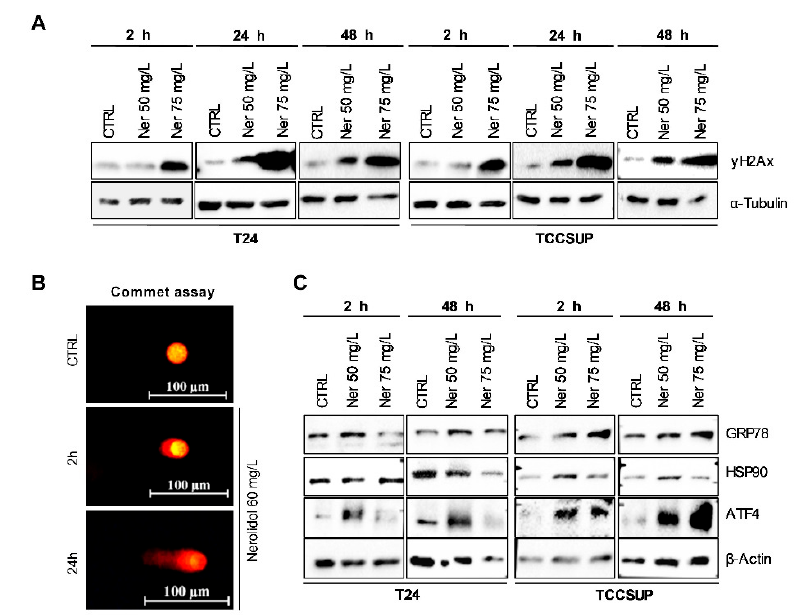
Figure 2. Prolonged nerolidol exposure caused increasing levels of DNA damage and ER stress. ( A ) γ H2Ax immunostaining on T24 (left) and TCCSUP (right) cells after treatment with 50 and 75 mg/L of nerolidol for 2, 24, and 48 h. ( B ) Representative images of comet assay results on T24 cells treated with 60 mg/L of nerolidol for 2 and 24 h. ( C ) Immunostaining of ER stress markers GRP78, HSP90, ATF4, and GADD153 (CHOP) on T24 (left) and TCCSUP (right) cells after treatment with 50 and 75 mg/L of nerolidol for 2 and 48 h. The uncropped blots and molecular weight markers are shown in Supplementary F i le S1